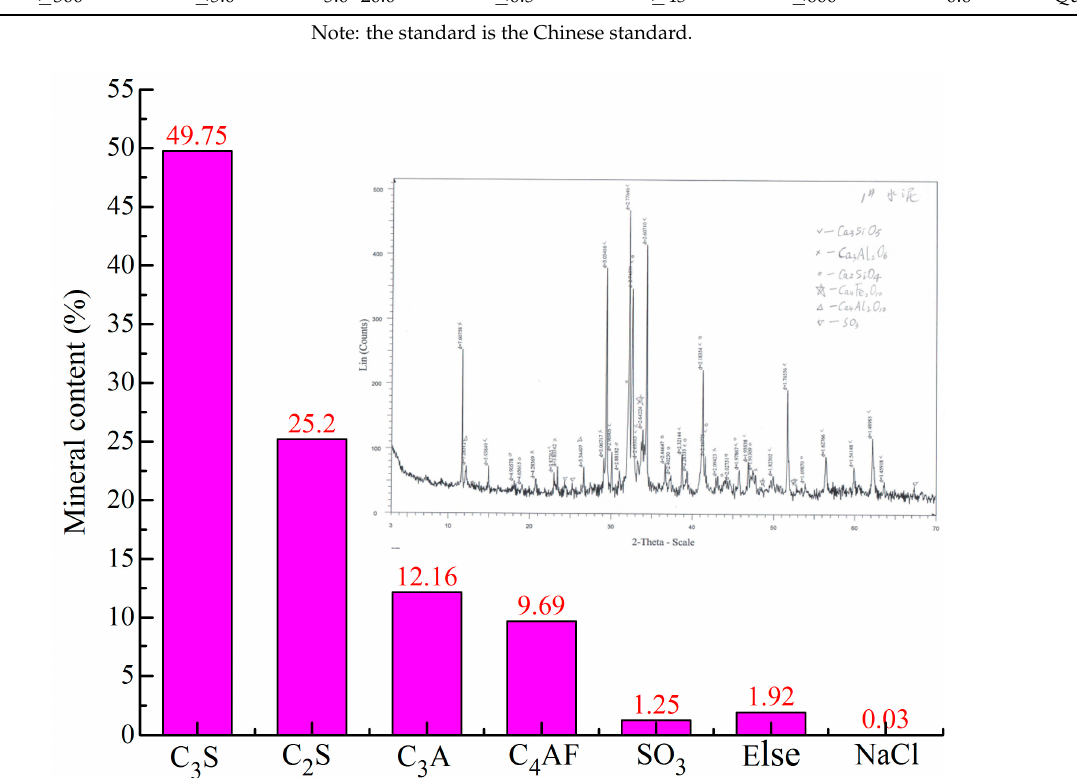
Table 2. The quality of the regular tap water (RW).